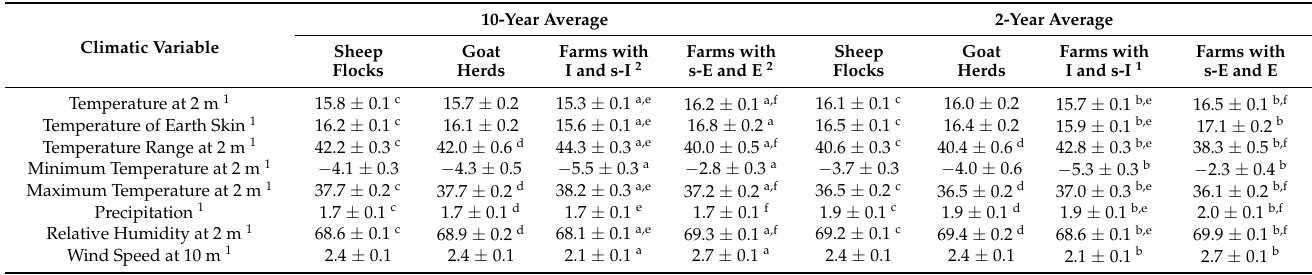
Table 1. Mean ( ± standard error) for climatic variables that prevailed in the farms during the 10 and 2 years prior to the study.